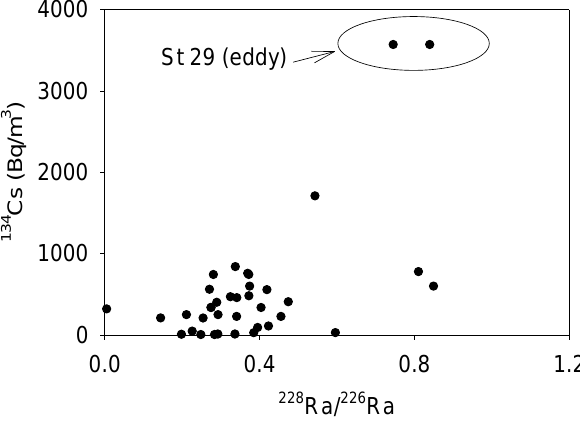
Fig. 4. Radium-derived water mass age (days) versus 134 Cs (Bqm − 3